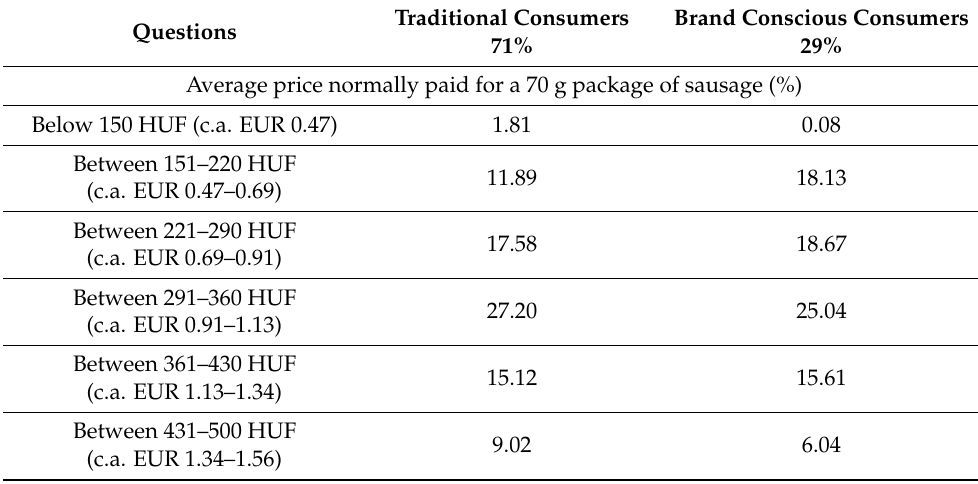
Table 8. Purchasing and consumption habits of classes based on the latent class